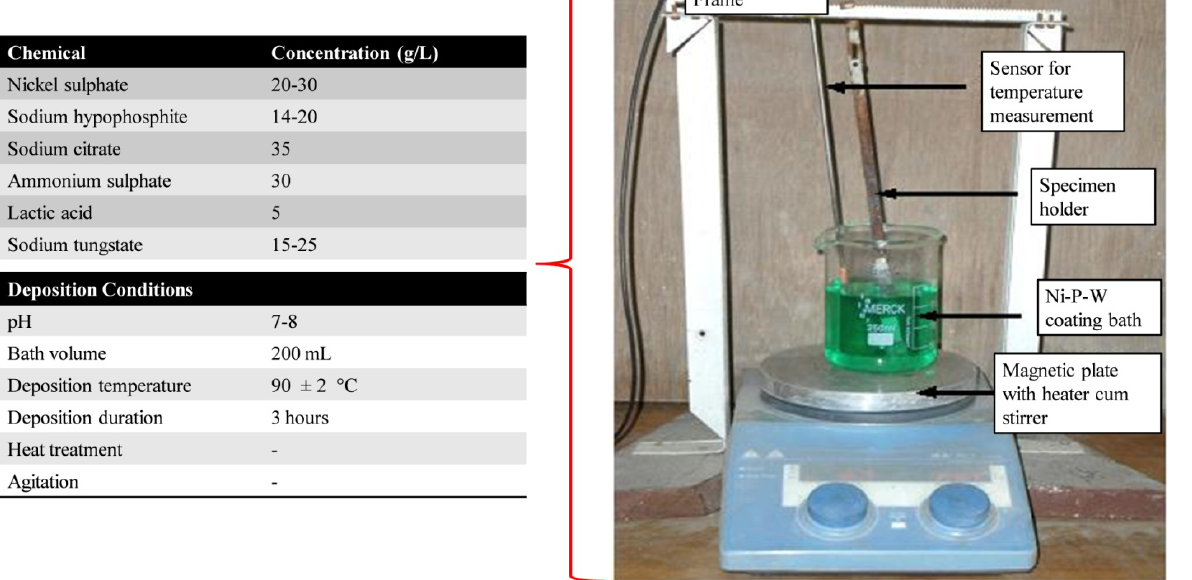
Figure 2. Coating bath along with composition and deposition